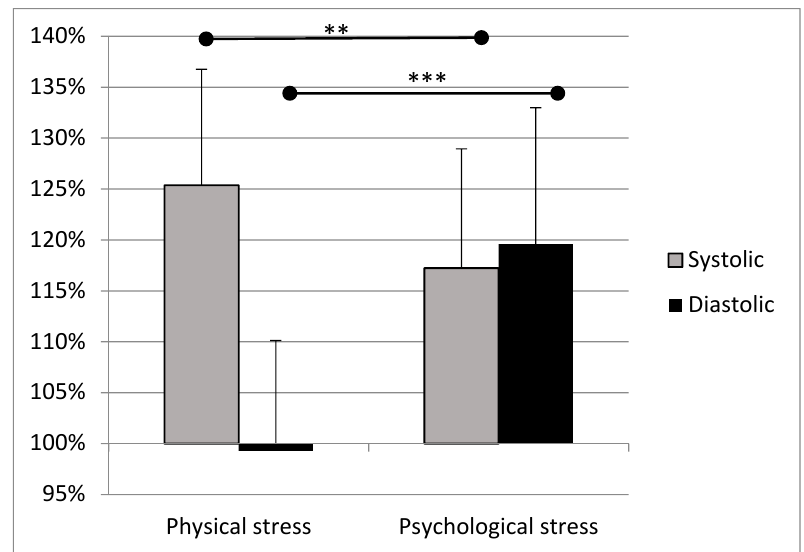
Figure 2. Average changes in blood pressure values between pre- and post-test. Pre-test data are considered to be 100%, represented by the X-axis. The measurement of change is expressed in percentages (vertical axis) for both test protocols. The differences in change in both systolic and diastolic BP results differed significantly between the test protocols (mean ± standard deviation; **: p < 0.01; ***: p < 0.001).